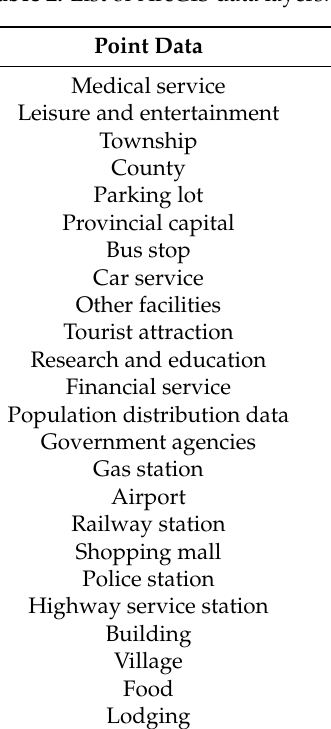
Table 2. List of ArcGIS data